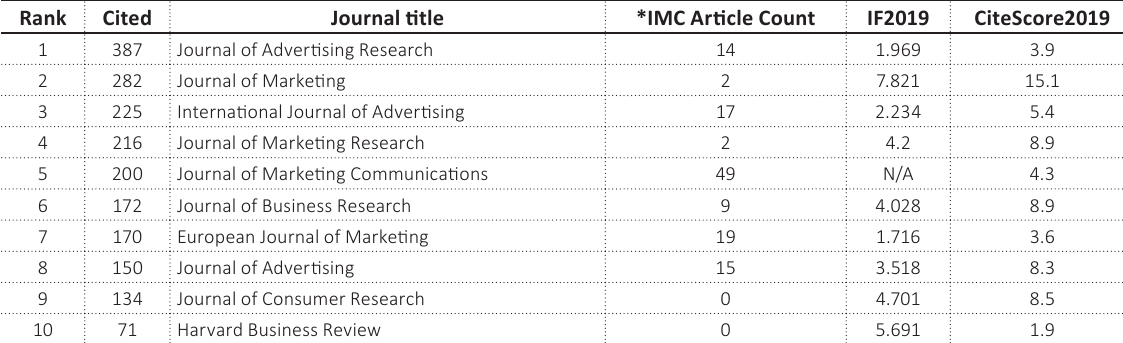
Table 3. The most cited journals in IMC research